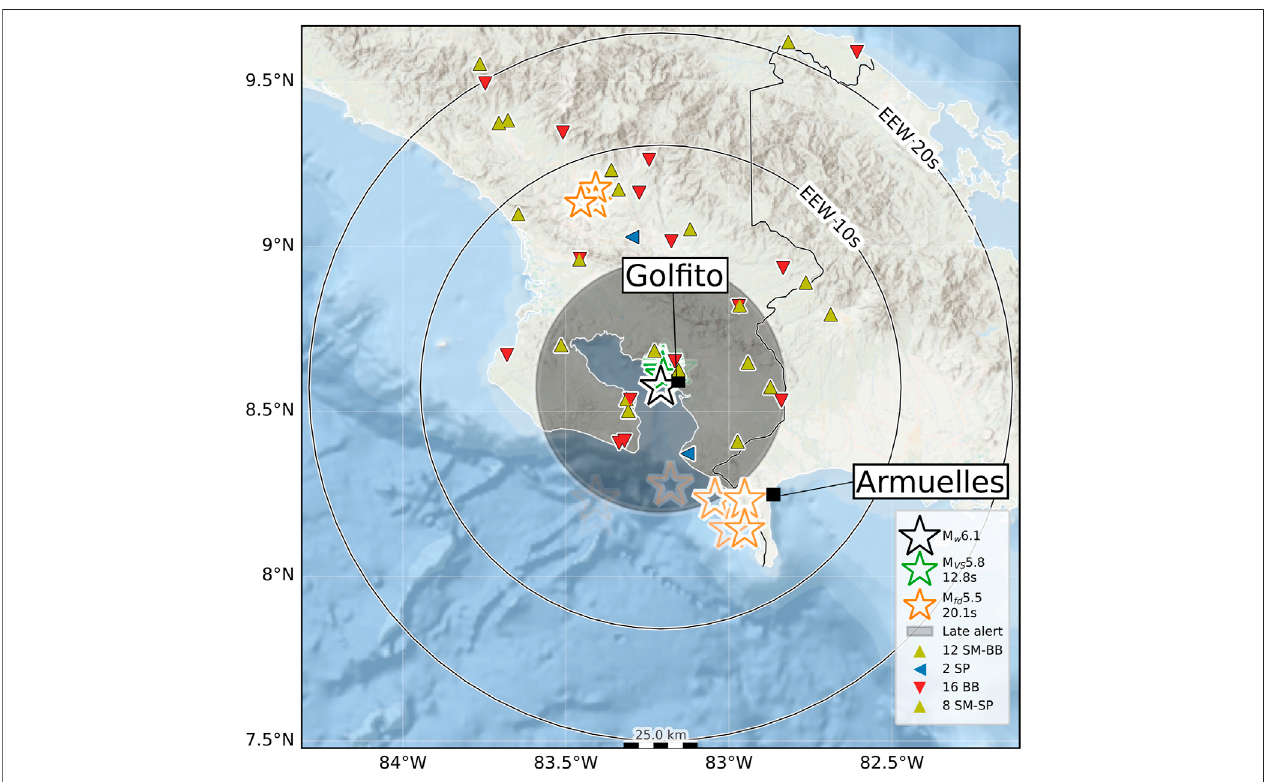
FIGURE 3 | Map of the 2018 Gol fi to earthquake (Mw 6.1). Solutions provided by VS and FinDer are shown as green and orange stars, respectively. The RSN locationisrepresentedasablack star(Arroyoand Linkimer, 2021).Trianglesrepresenttheseismicstations andarecolorcoded(seeinset)basedonthesensortype, as shortperiod(SP),broadband(BB),andstrongmotion(SM).SPstationsareusedbyVS,butnotbyFinDer.TheblindzoneistheconcentricshadowareaaroundtheRSN location and represents the late alert zone. The thin black circles represent the warning time at different distances from the epicenter.